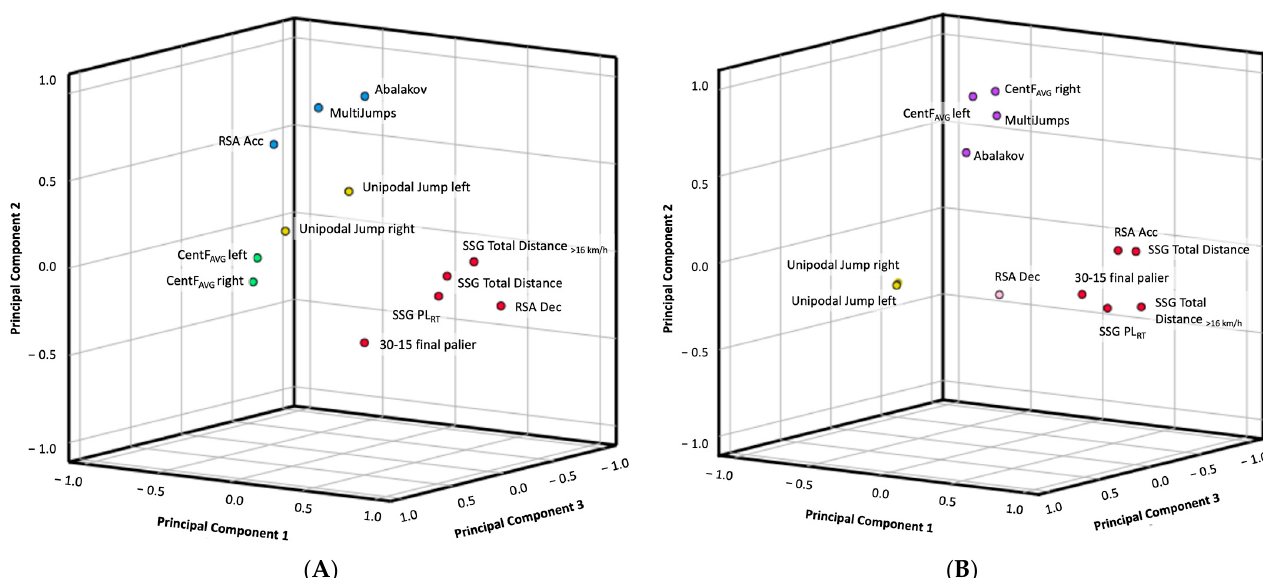
Figure 2. Rotated principal component distribution of physical fitness profile in ( A ) male and ( B ) female semiprofessional basketball players. Each color of the filled circles represents one principal component. In male players, PC1 is represented with red, PC2 with blue, PC3 with green and PC4 with yellow. In female players, PC1 is represented with red, PC2 with purple, PC3 with yellow and PC4 with pink. Red and yellow colors are shown in male and female players due to these components were found in both sexes.